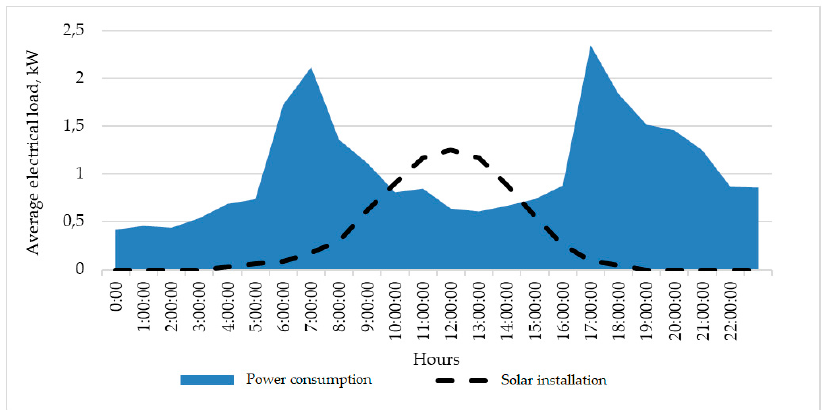
Figure 5. Household electrical load graph on a working day with a superimposed graph of electricity generated by solar installations.